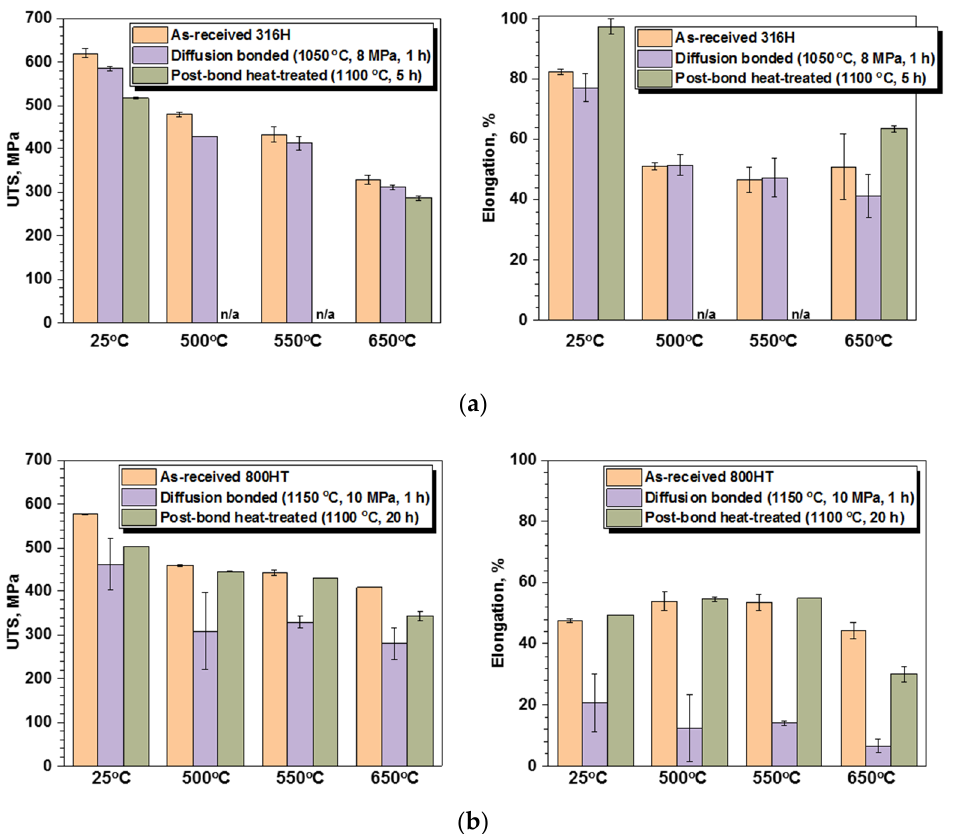
Figure 4. Tensile test results of PBHT-ed ( a ) SS 316H and ( b ) Alloy 800HT compared to as-received and diffusion bonded conditions.